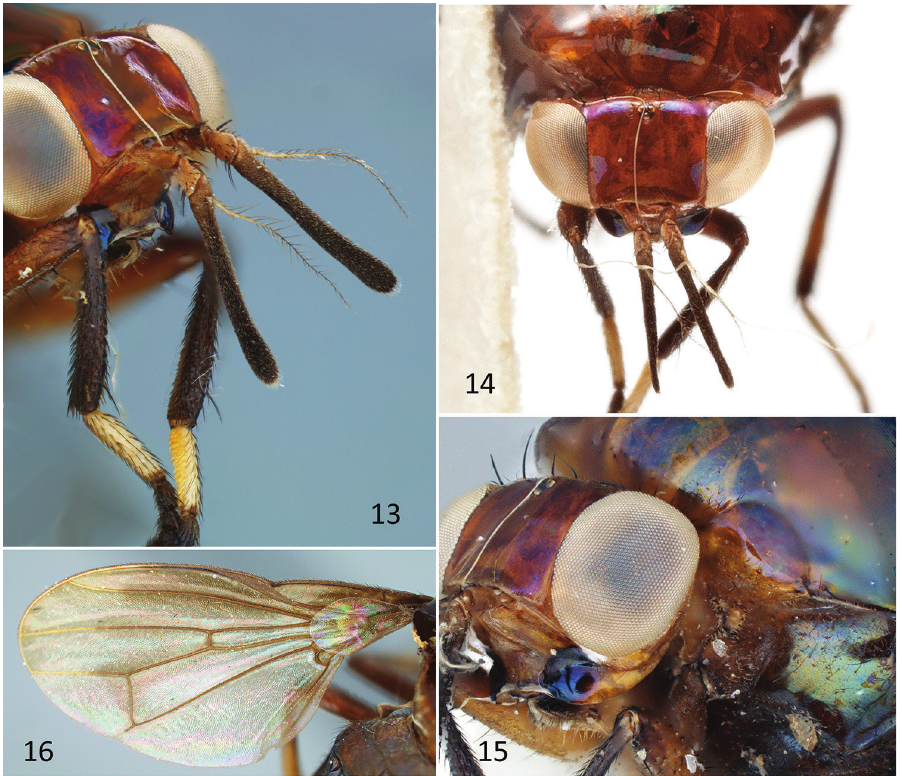
Figures 13–16. Atopocelyphus ruficollis (Macquart), female specimen (BMNH). 13 Head and forelegs, anterolateral 14 Head, dorsal 15 Head and anterior part of pleuron, anterolateral 16